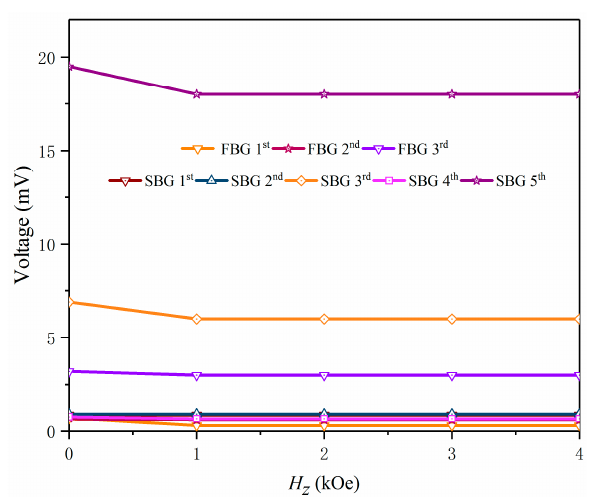
Figure 15. The output voltage of defect bands ( Z mode) versus the magnetic field when σ z = 0 MPa, R = 20 kΩ .